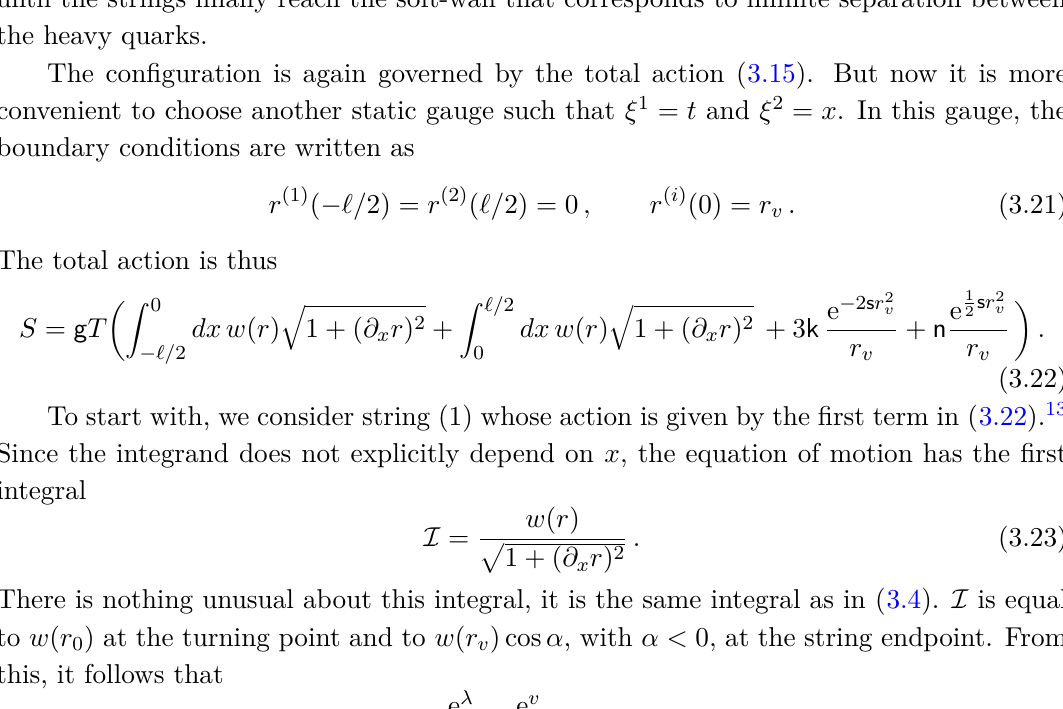
Figure 3 . A static configuration at large heavy quark separations. For string (1) a turning point is located at ( x 0 , r 0 ) . The soft wall is at r w = 1 / point r = r v